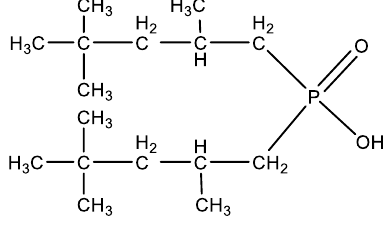
Figure 2. Structure of Cyanex 272.